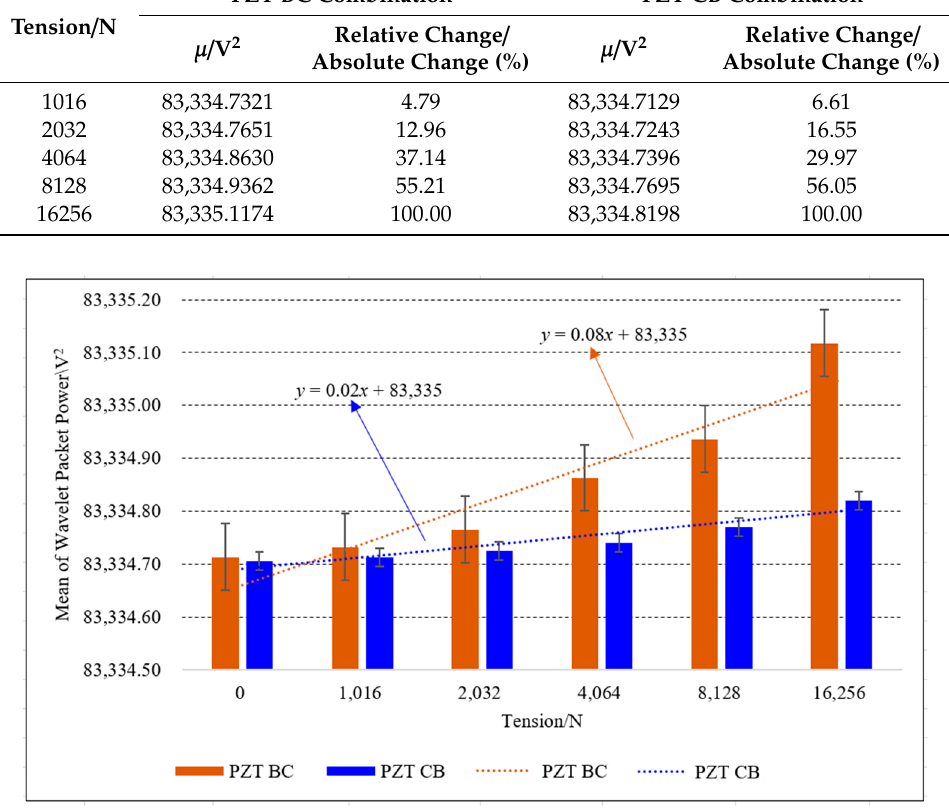
Figure 22. Mean of the wavelet packet energy of two PZT BC combinations.